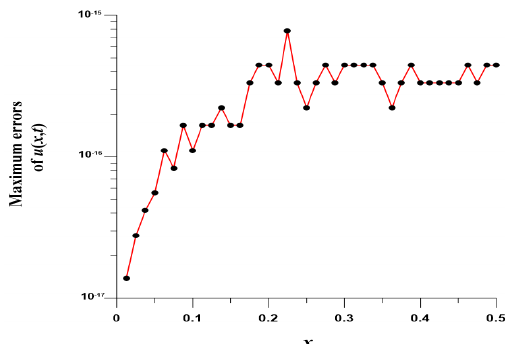
Figure 7. For Example 3: ME( u ) versus x at